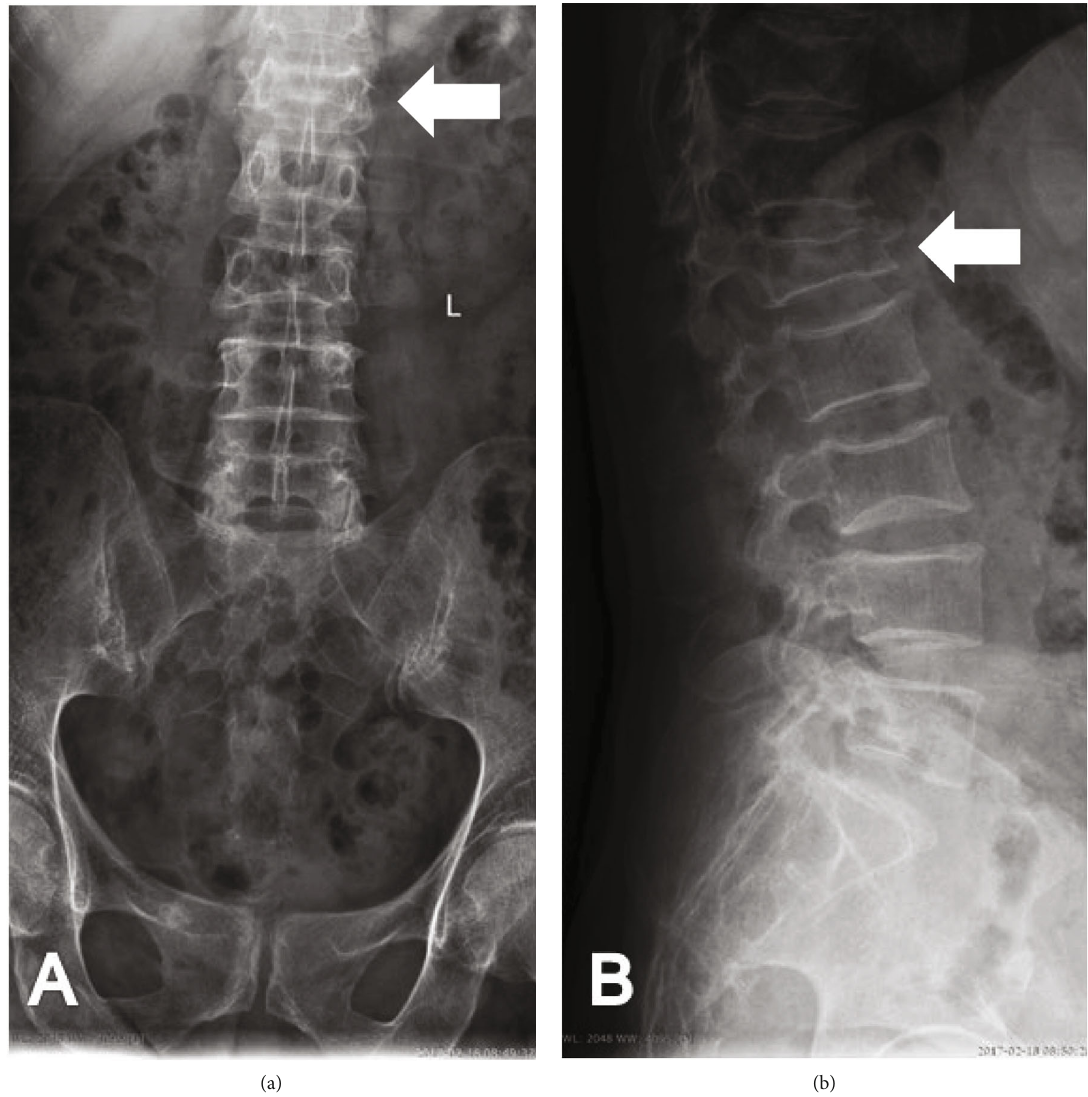
Figure 1: Radiographs showing the advanced osteoporosis with pathological fracture of the fi rst lumbar vertebra (L1) in anteroposterior (a) and lateral (b) view. White arrows indicate the fracture